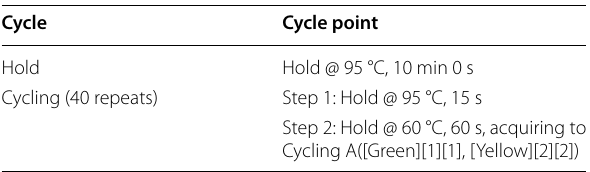
Table 1 Thermal cycler profile Cycle Cycle